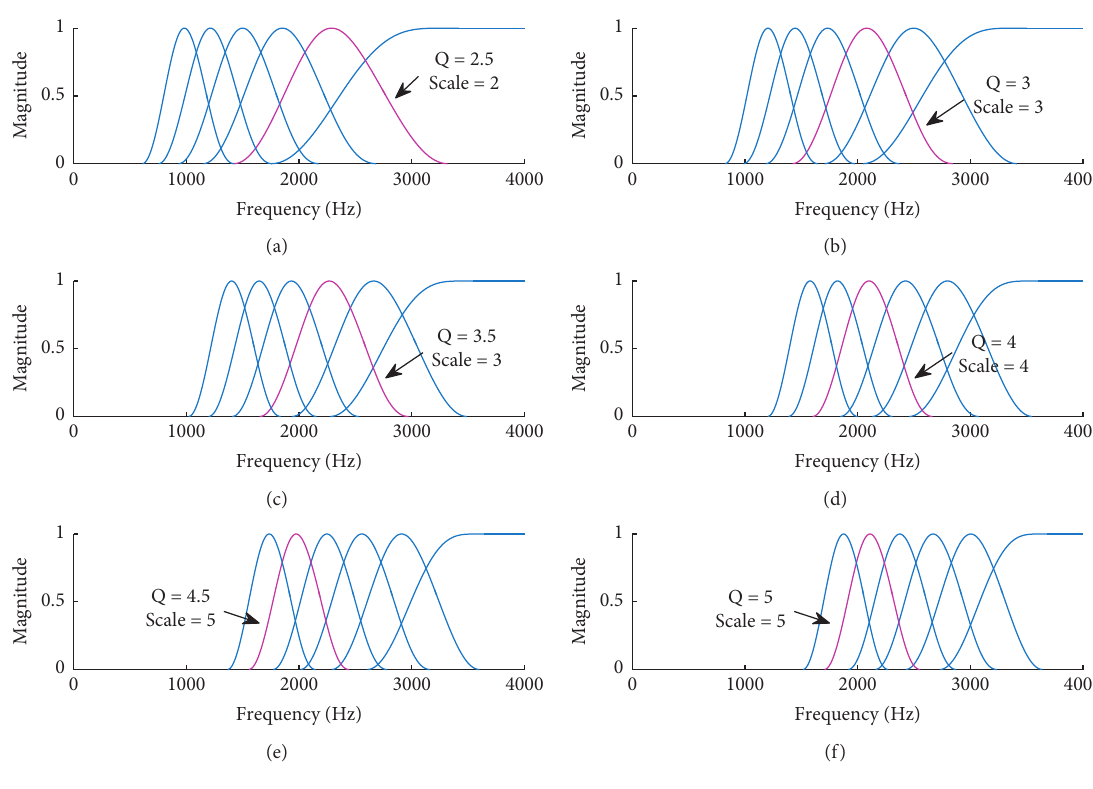
Figure 6: Equivalent filtering characteristics of subbands with different Q-values and scales.